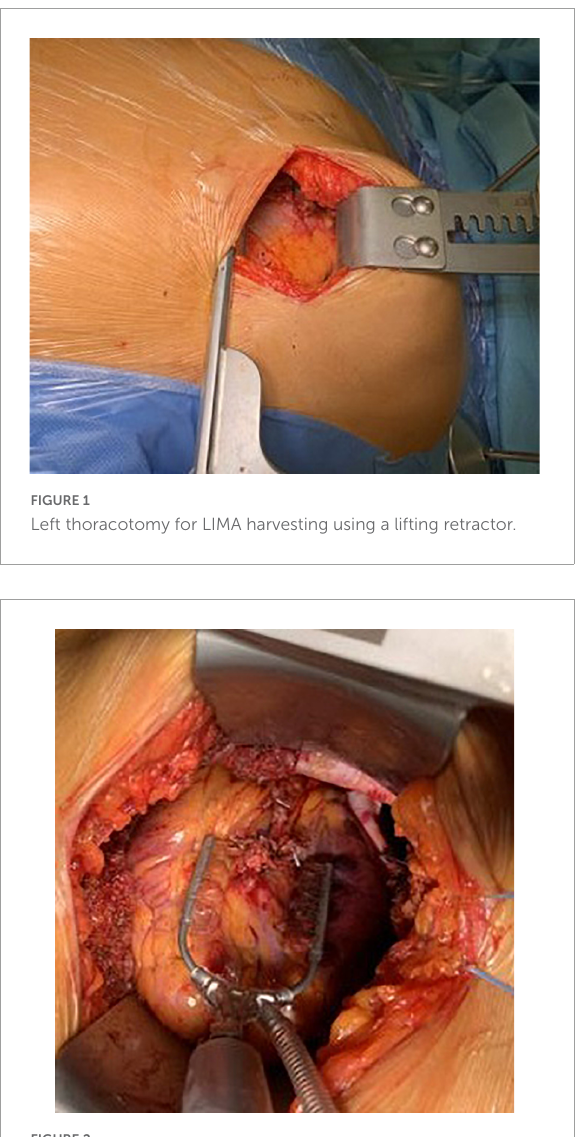
FIGURE2 Minimally invasive direct coronary artery bypass, LIMA, to LAD